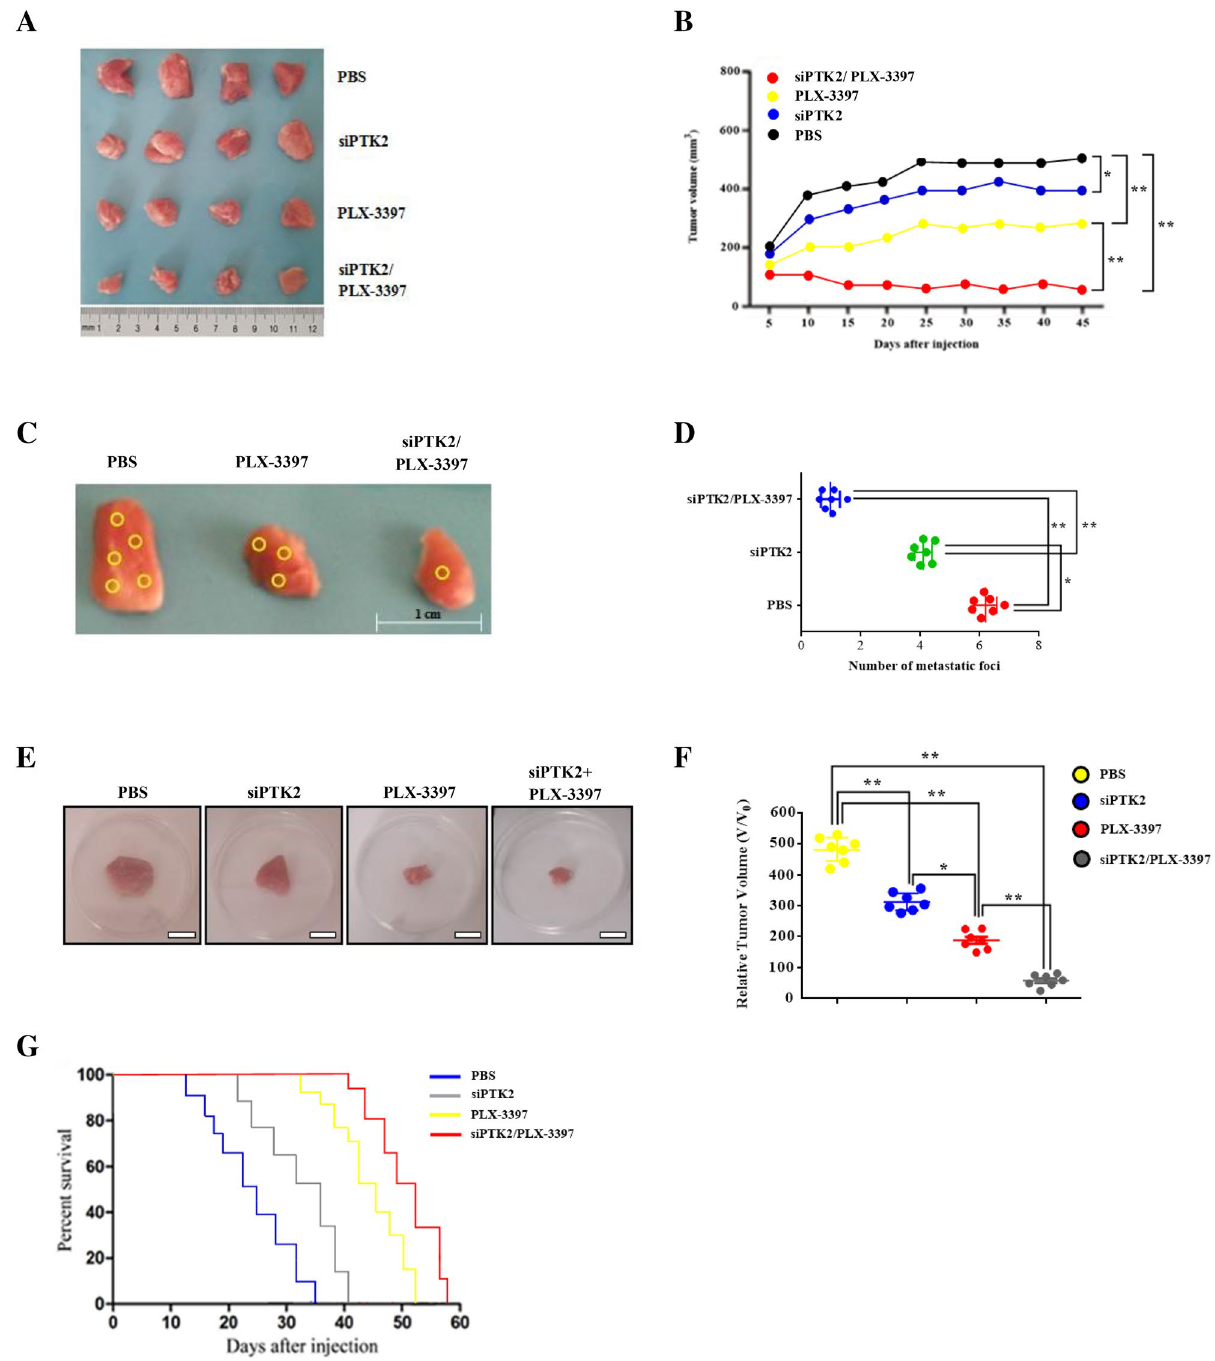
Figure 5. Co-inhibition of circPTK2 and M2 polarization reduces tumor volume and metastatic foci development. ( A ) Characteristic images of excised tumors from mice following si-circPTK2/PLX-3397 treatment. ( B ) Tumor volume analysis of mice treated at various groups. ( C ) In vivo metastatic analysis of lymph node metastasis from si-circPTK2/PLX-3397-treated groups. Images show representative lymph node metastatic foci highlighted in yellow from different groups. ( D ) Statistical analysis of the number of metastatic foci of each group. ( E ) Representative photographs of excised tumors from C57BL/6 mice after intravenous treatment with si-circPTK2/PLX-3397. ( F ) Relative tumor volumes (V/V0) of A549 tumor bearing mice following intravenous administration. ( G ) Survival rates of tumor-bearing mice after a 60-day tumor challenge in each group. Data were given as the mean ± SD (n = 6) (*p < 0.05, **p < 0.01). Data represent the mean ± SD of three independent